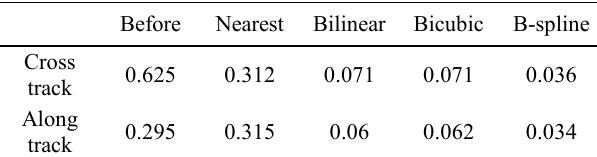
Table 2. Standard variations of the registration errors before compensation and after compensation with different interpolators (Nearest, Bilinear, Bicubic, B-spline) in two directions (Unit: pixel).